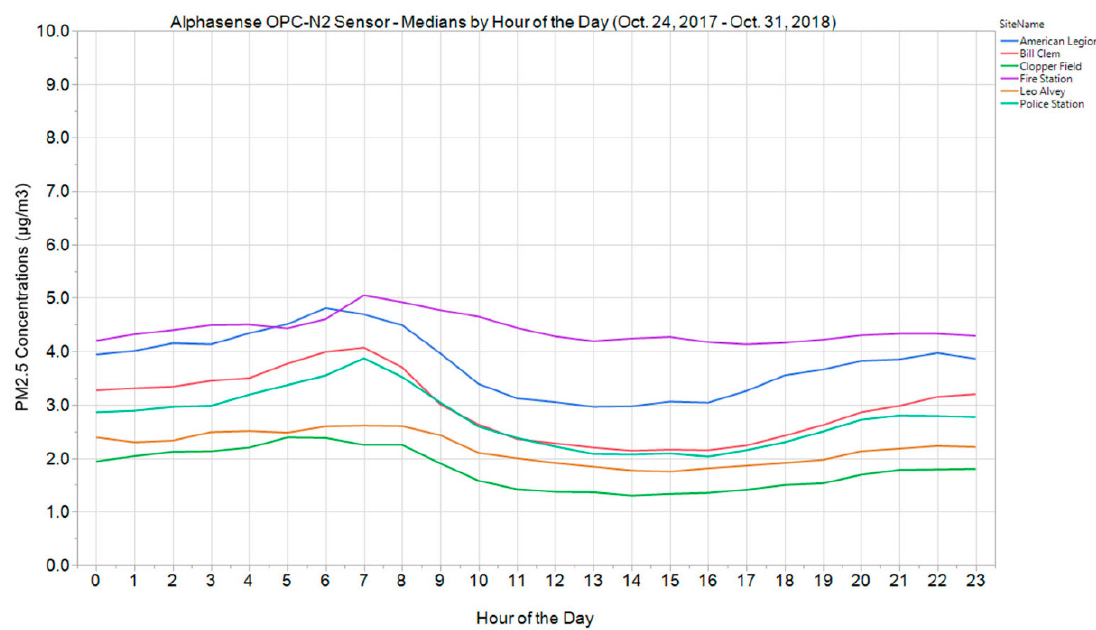
Figure 8. Diurnal Median PM 2.5 Concentrations (µg/m 3 ).